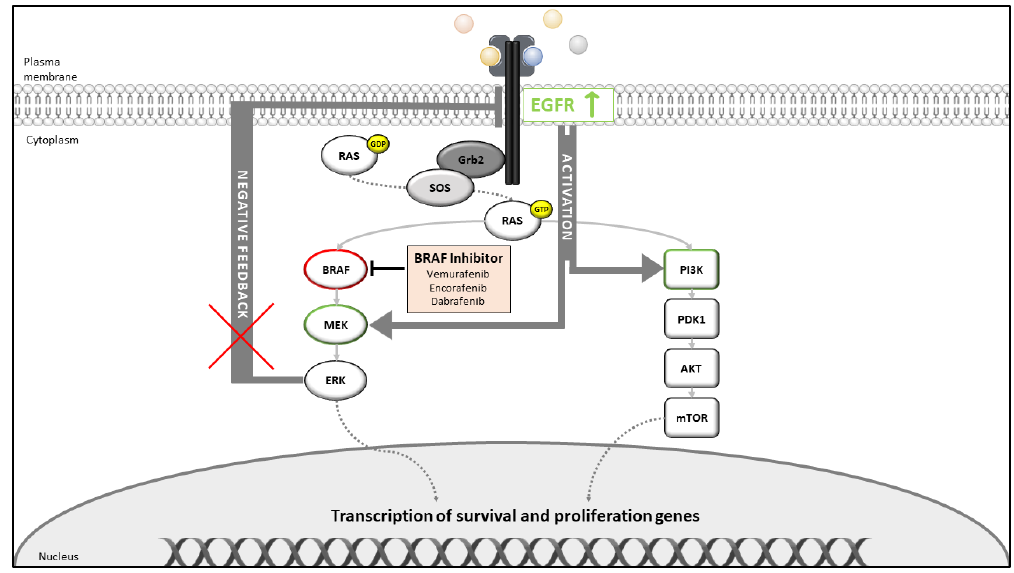
Figure 3. Feedback mechanisms of the BRAF inhibitor monotherapy. BRAF inhibitors suppress the ERK-mediated negative feedback phosphorylation of EGFR (x, red cross), leading to increased EGFR ( ↑ , green arrow)/RAS activity, which then results in the activation of the RAF family member CRAF or the PI3K/AKT pathway, © Silvia Eller.